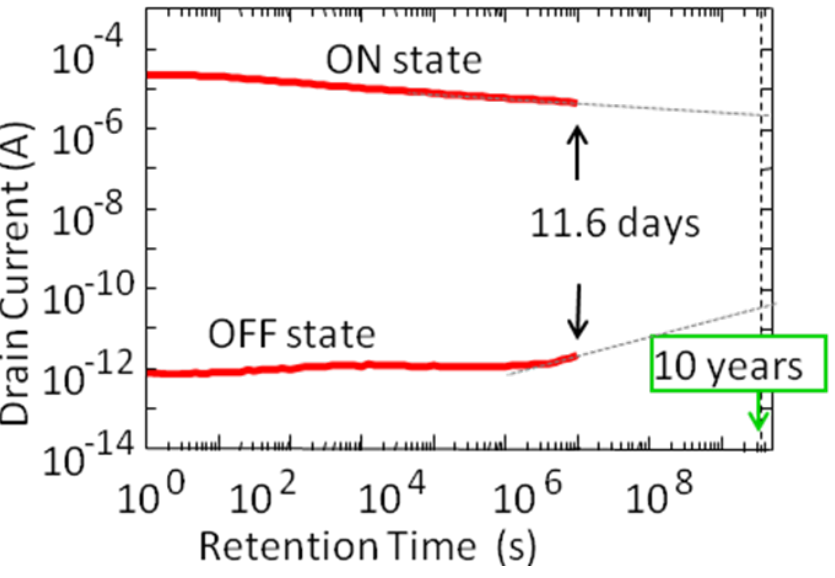
Figure 3. Drain current retention of a Pt/SBT/Hf-Al-O/Si FeFET. Potential 10 year retention is indicated by the extension lines on the measured retention curves. Modified from [15].